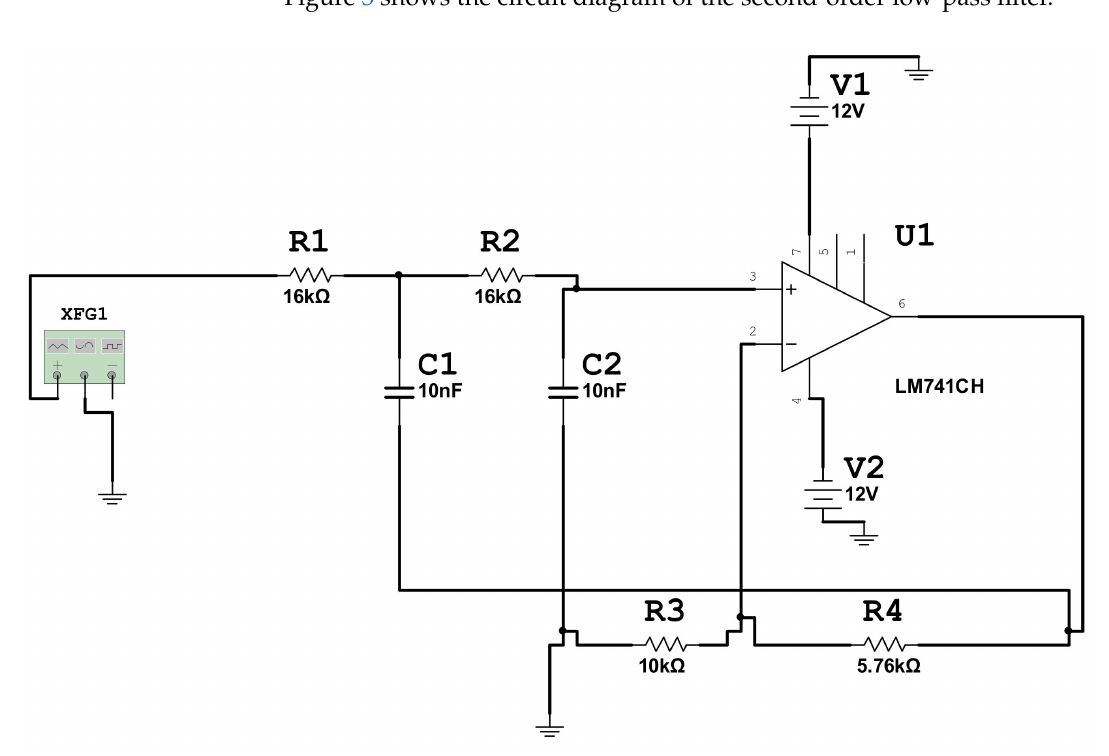
Figure 3. The schematic diagram for the active low-pass filter